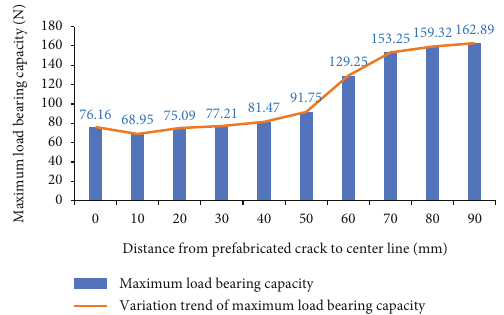
Figure 7: The change curve of the bearing capacity of concrete three-point bending beams with di ff erent value a .